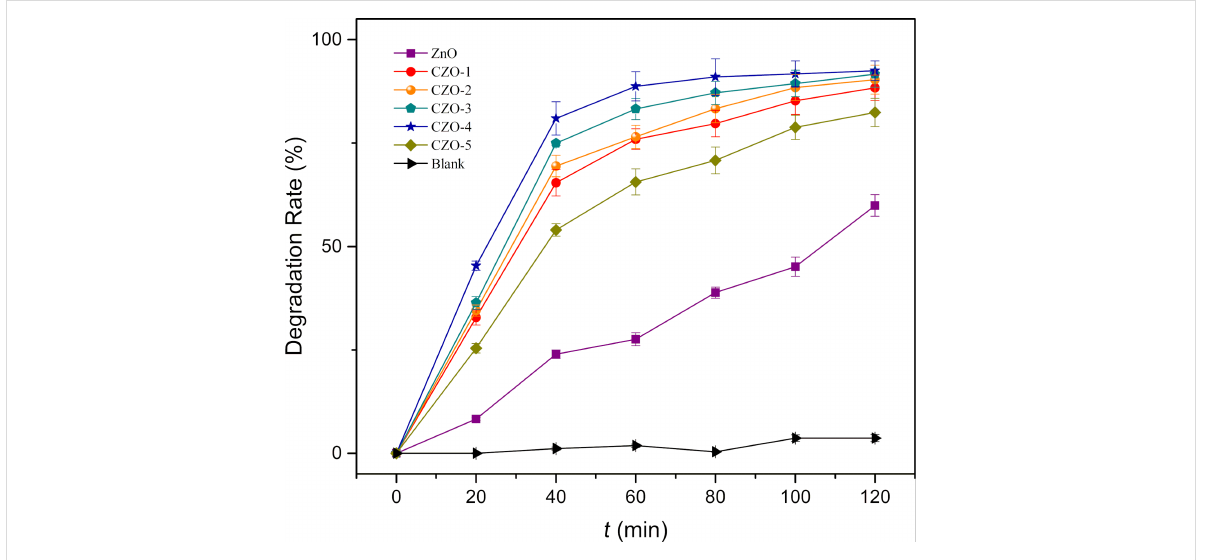
Figure 1: Photocatalytic activity of samples with different Ce doping percentages.